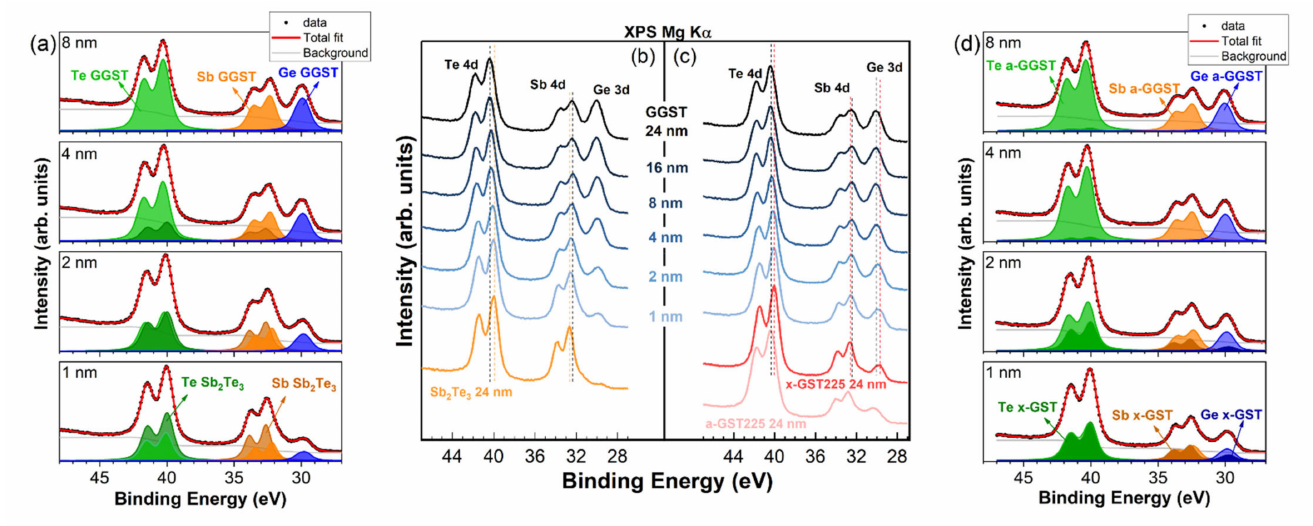
Figure 2. XPS spectra evolution of the Te 4d, Sb 4d, and Ge 3d core levels for ( b ) sample A, ( c ) sample B at increasing thicknesses of the GGST film. Chemical shifts toward higher and lower BEs are visible for Te 4d, Ge 3d, and Sb 4d, respectively. Fit deconvolution of the core levels for selected thicknesses (1, 2, 4, and 8 nm) of the deposited GGST layer is also shown for ( a ) sample A, ( d ) sample